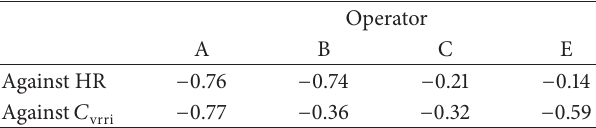
Table 7: Correlation coefficients between the estimated skill level and indexes of internal status. Operator A B C Against 𝐶